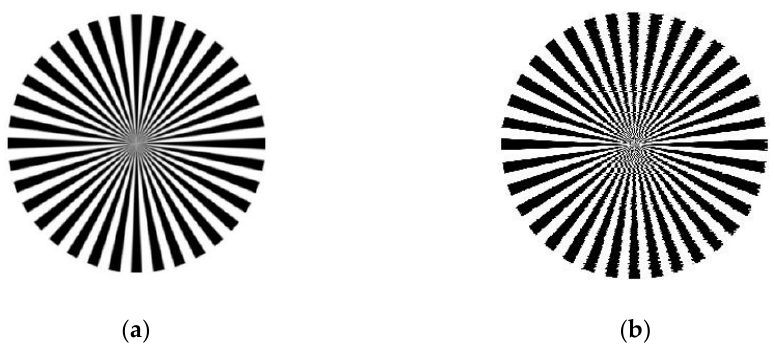
Figure 8. ( a ) Examples of the transmitted images; ( b ) received images of a sector “mira” for the same observation conditions as in Figure 7 at time moment 3.